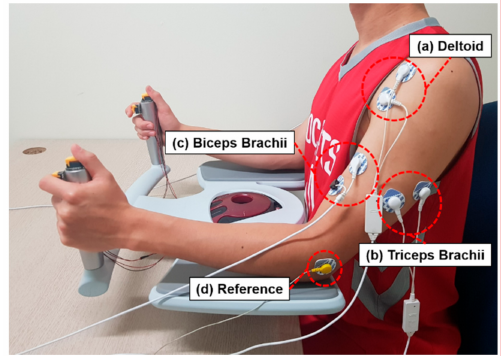
Figure 4. Positions of the electrodes attached to collect sEMG